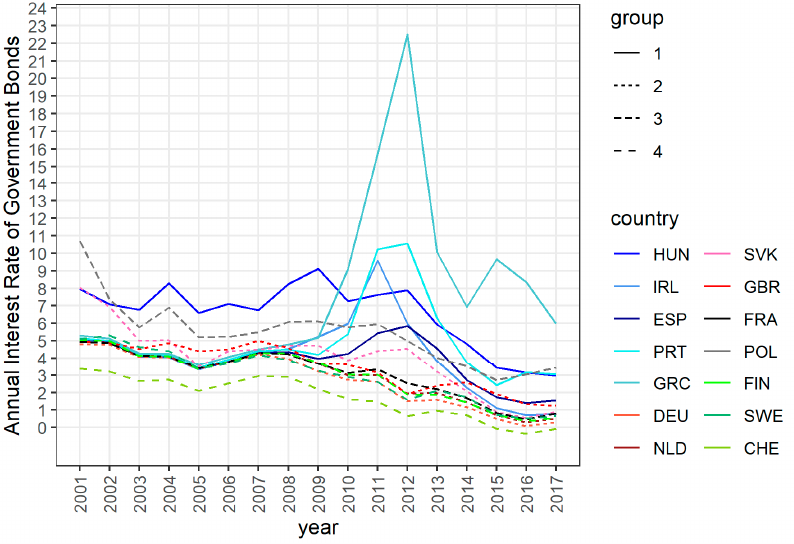
Figure 4. The development of the annual interest rate of government bonds in analyzed countries.